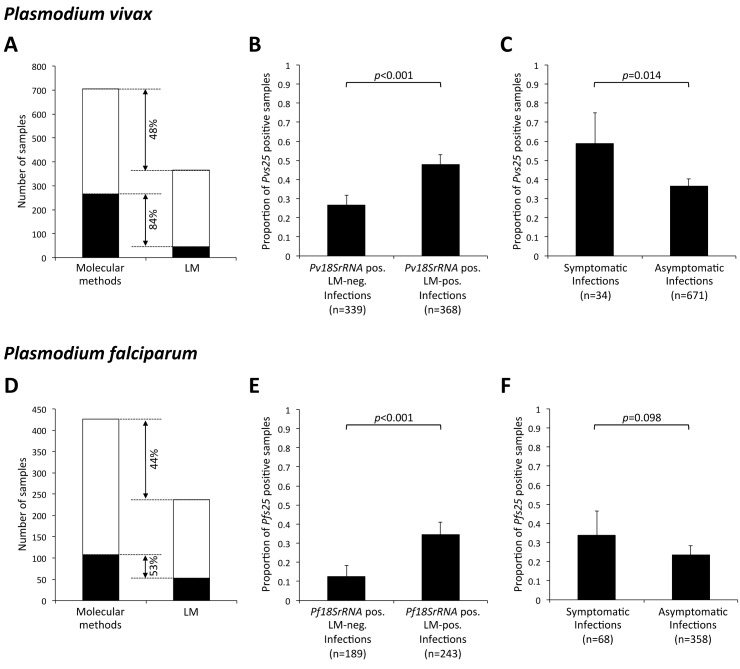
Pv (top) and Pf (bottom) gametocyte positivity among 5019 follow-up samples.(A, D) Detection of blood stage parasites and gametocytes by LM and molecular methods, using pv18S or pf18S rRNA qPCR for detection of blood-stage parasites and pvs25 or pfs25 qRT-PCR for detection of gametocytes. Black: gametocyte positive samples. White: parasite positive samples without gametocytes. (B, E) Proportion of gametocytes positives (by molecular methods) in submicroscopic and LM-positive samples. (C, F) Proportion of gametocyte positives (by molecular methods) in symptomatic and asymptomatic infections. Error bars indicate 95% confidence intervals by X2 distribution.